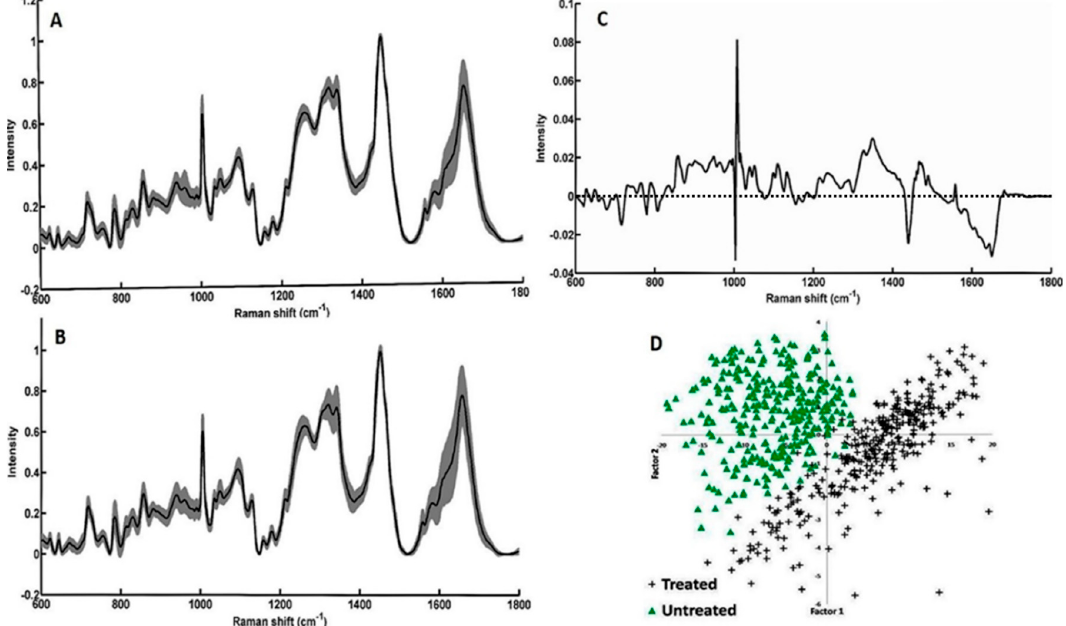
Figure 4. Mean baseline corrected spectrum along with standard deviation (shaded region) acquired from group of cells: ( A ) Untreated; ( B ) Treated; ( C ) difference spectrum (Untreated − treated); and ( D ) PCA scatter plot.